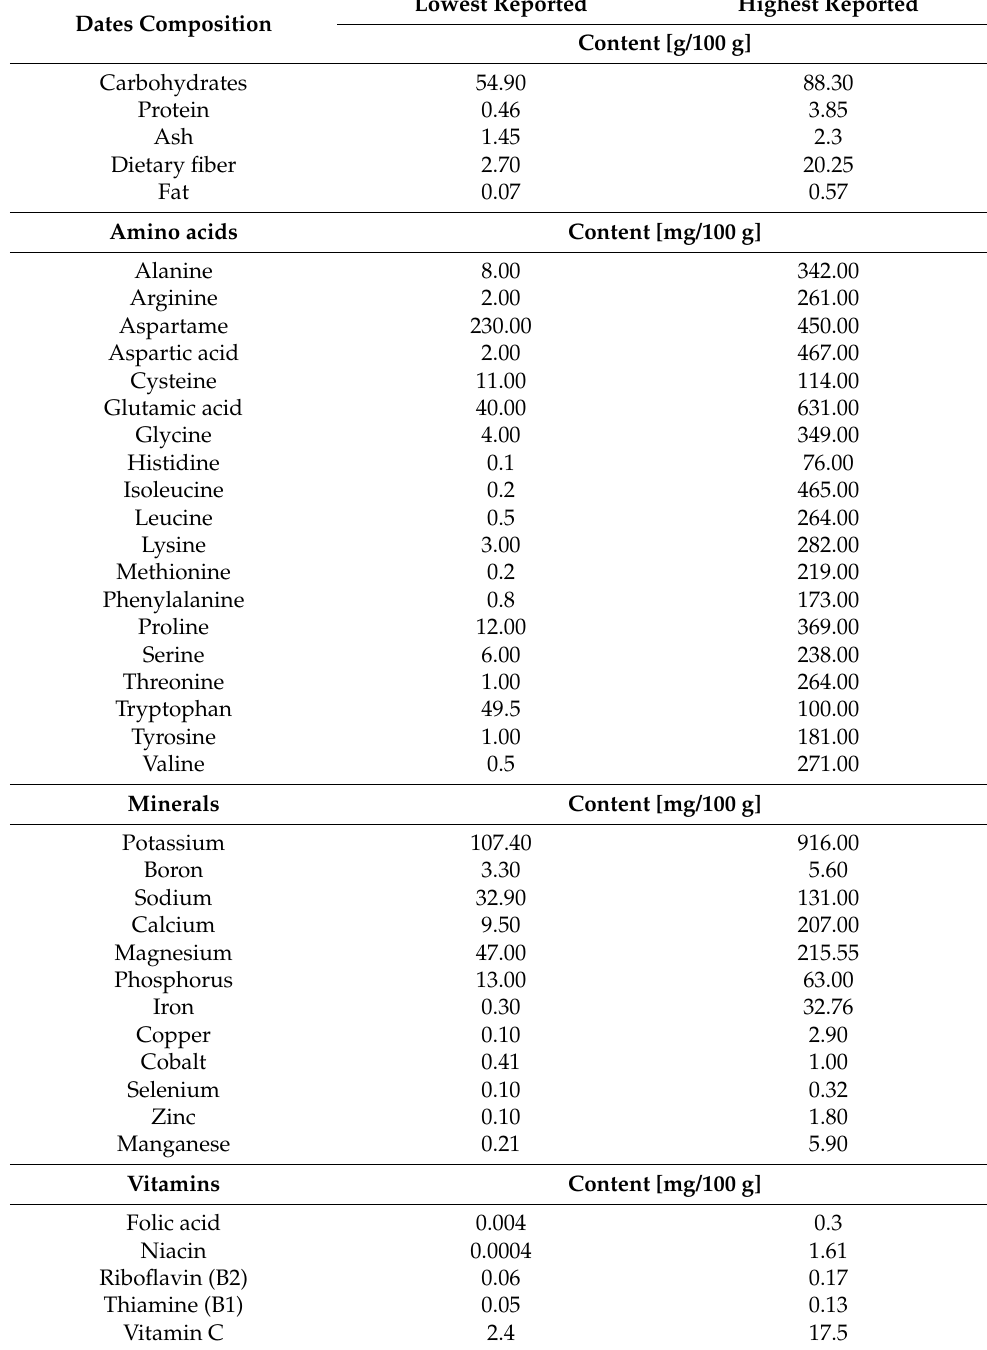
Table 1. Composition of date fruits at tamer stage. Values are reported as weight/100 g dry matter. Adapted from